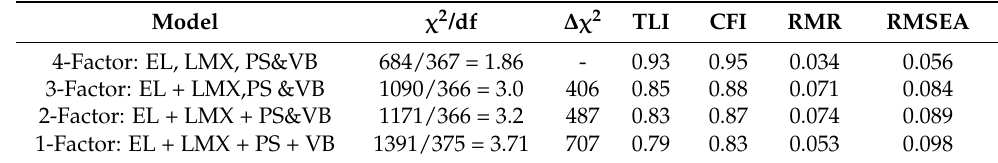
Table 1. CFA models